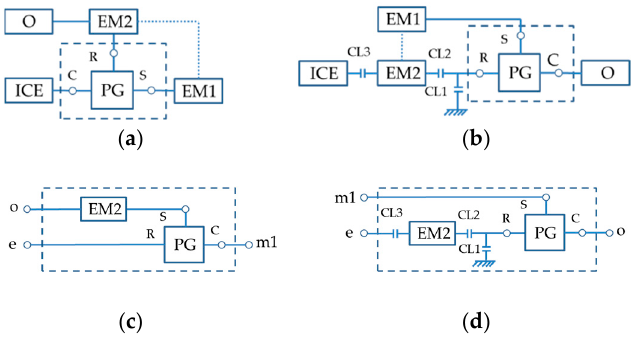
Figure 18. Type-a architecture: ( a ) Clutchless system-THS; ( b ) With clutch system-Volt; ( c ) Three-port diagram of THS; ( d ) Three-port diagram of Volt.